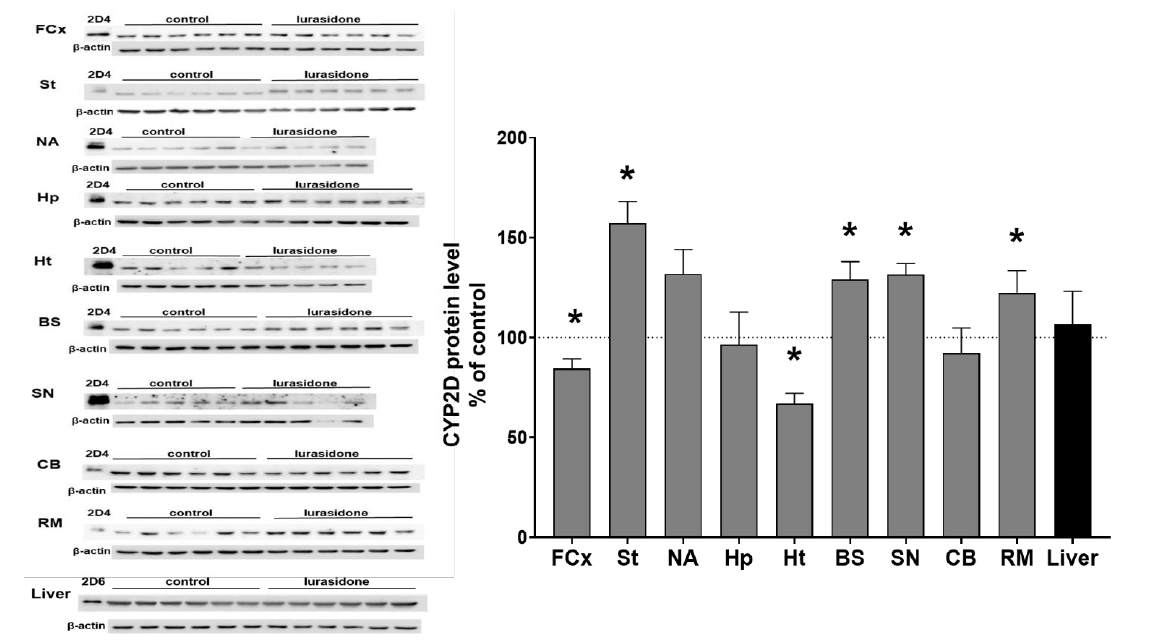
Figure 2. The effect of two-week treatment with lurasidone on the CYP2D protein levels measured in microsomes derived from the selected brain structures or liver. The presented values are the means ± S.E.M. of 15 samples (from 15 animals) for the cerebellum, remainder of brain, and the liver; of 7 samples (each sample contained 2 pooled brain structures from 2 animals) for the frontal cortex, brain stem, striatum, and hippocampus; or of 5 samples (each sample contained 3 pooled brain structured from 3 animals) for the hypothalamus, nucleus accumbens, and substantia nigra. The representative CYP2D protein bands of the Western blot analysis are shown. Brain or liver microsomal protein (10 µ g) was subjected to Western blot analysis. cDNA-expressed CYP2D4 protein (Bactosomes) and cDNA-expressed CYP2D6 protein (Supersomes) was used as a positive control. Student’s t -test: * p < 0.05 vs. control group. FCx—the frontal cortex, St—the striatum, NA—the nucleus accumbens, Hp—the hippocampus, Ht—the hypothalamus, BS—the brain stem, SN—the substantia nigra, CB—the cerebellum, and RM—the remainder.